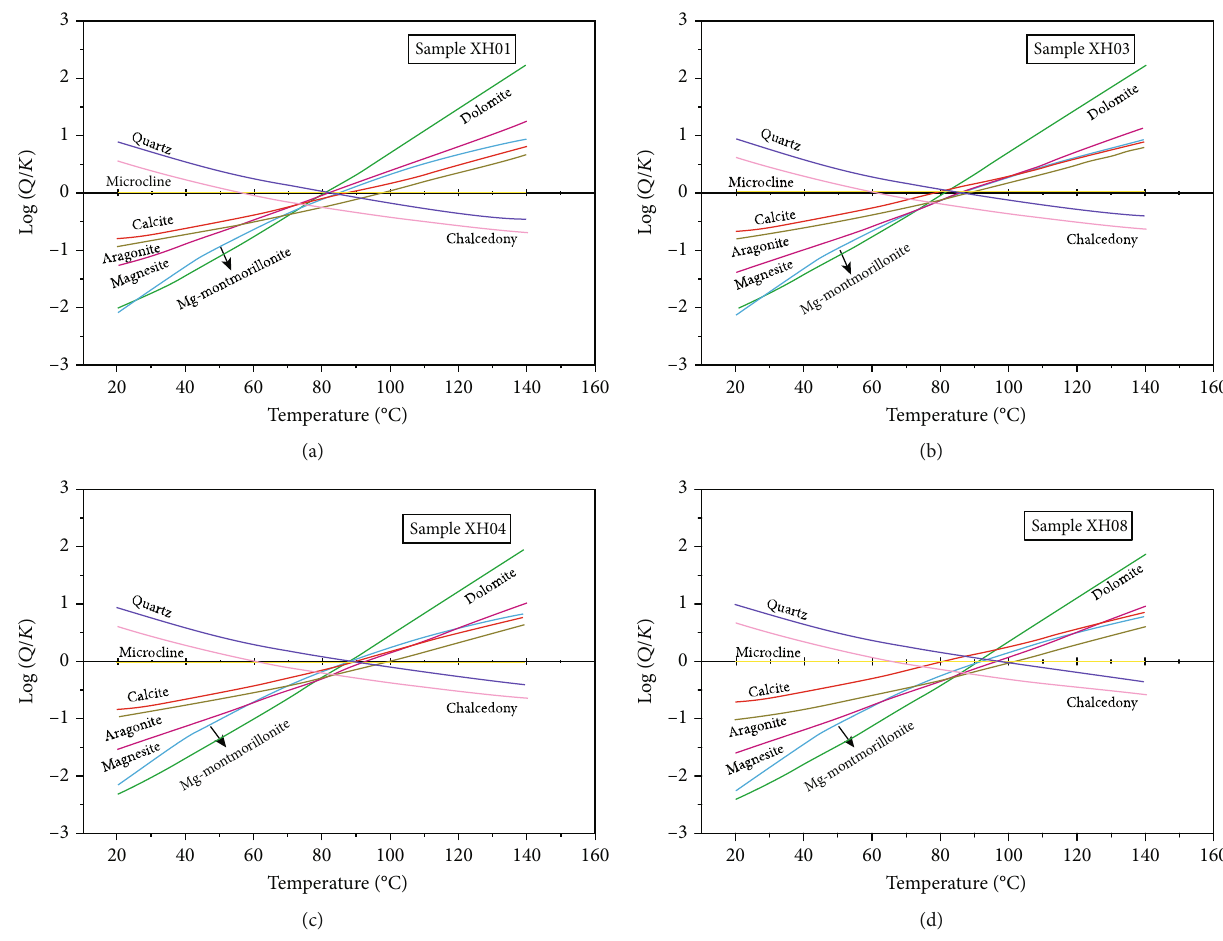
Figure 8: FixAl graph for the geothermal groundwater (a) XH01, (b) XH03, (c) XH04, and (d) XH08 at the Xiongxian site. The Al concentration is fi xed by microcline saturation, and the process of degassing is